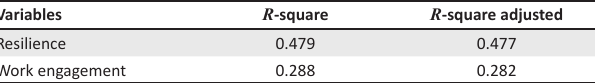
TABLE 7: R-squared represents the proportion of the variance in work engagement that is explained by resilience and work engagement. Variables